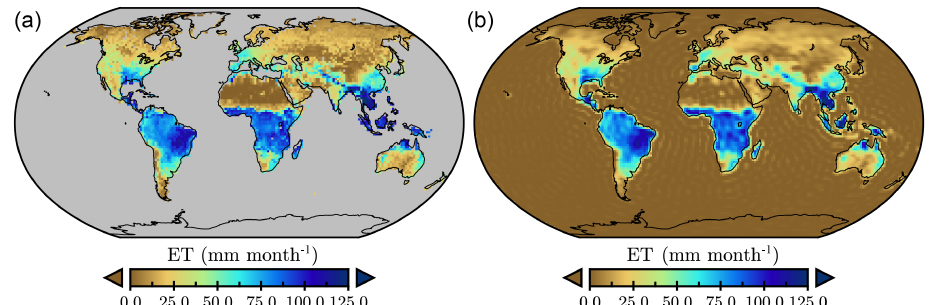
Figure 3. Left: CSIRO-PML monthly evaporation ( E ) for April 2003. Right: the same data set after spherical harmonic analysis and synthesis of the evaporation data. Missing data are set to zero. The data appear smoothed because they are an approximation (Eq. 1) limited by l max . There are also other effects such as ringing that are visible in regions where the data are close to